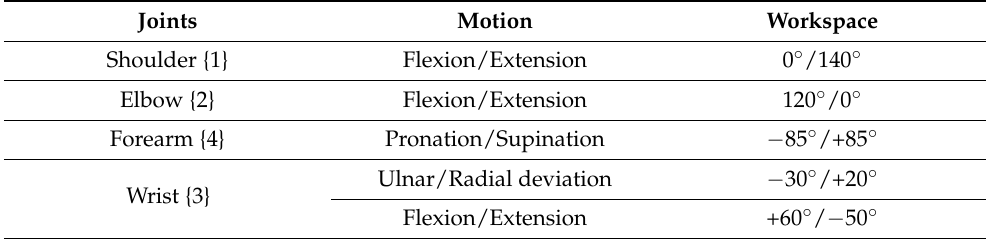
Table 2. Movements of the exoskeleton robot.